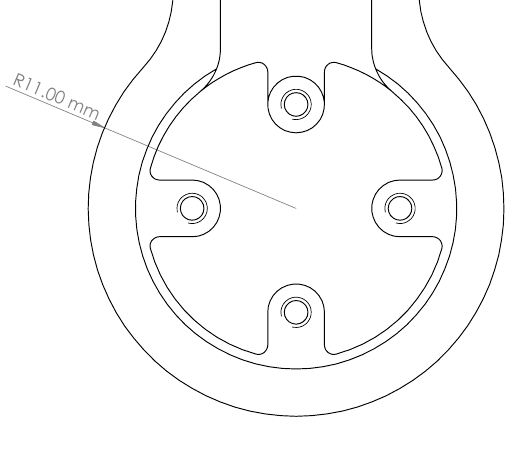
Figure 1. Bounding geometry of the sensor fixture used to fit the sensor to the hand rehabilitation